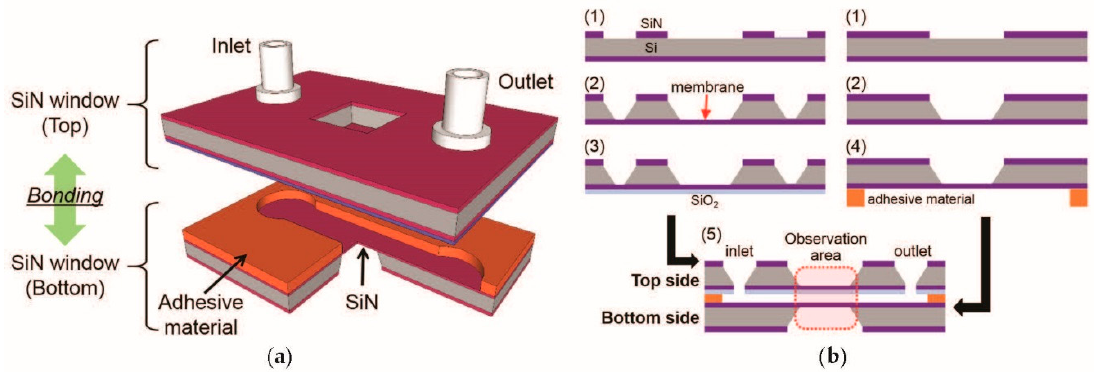
Figure 2. ( a ) Schematic illustration of the microfluidic device consisting of microchannel patterned with a photo patternable adhesive material and SiN membrane windows; ( b ) Fabrication procedure.